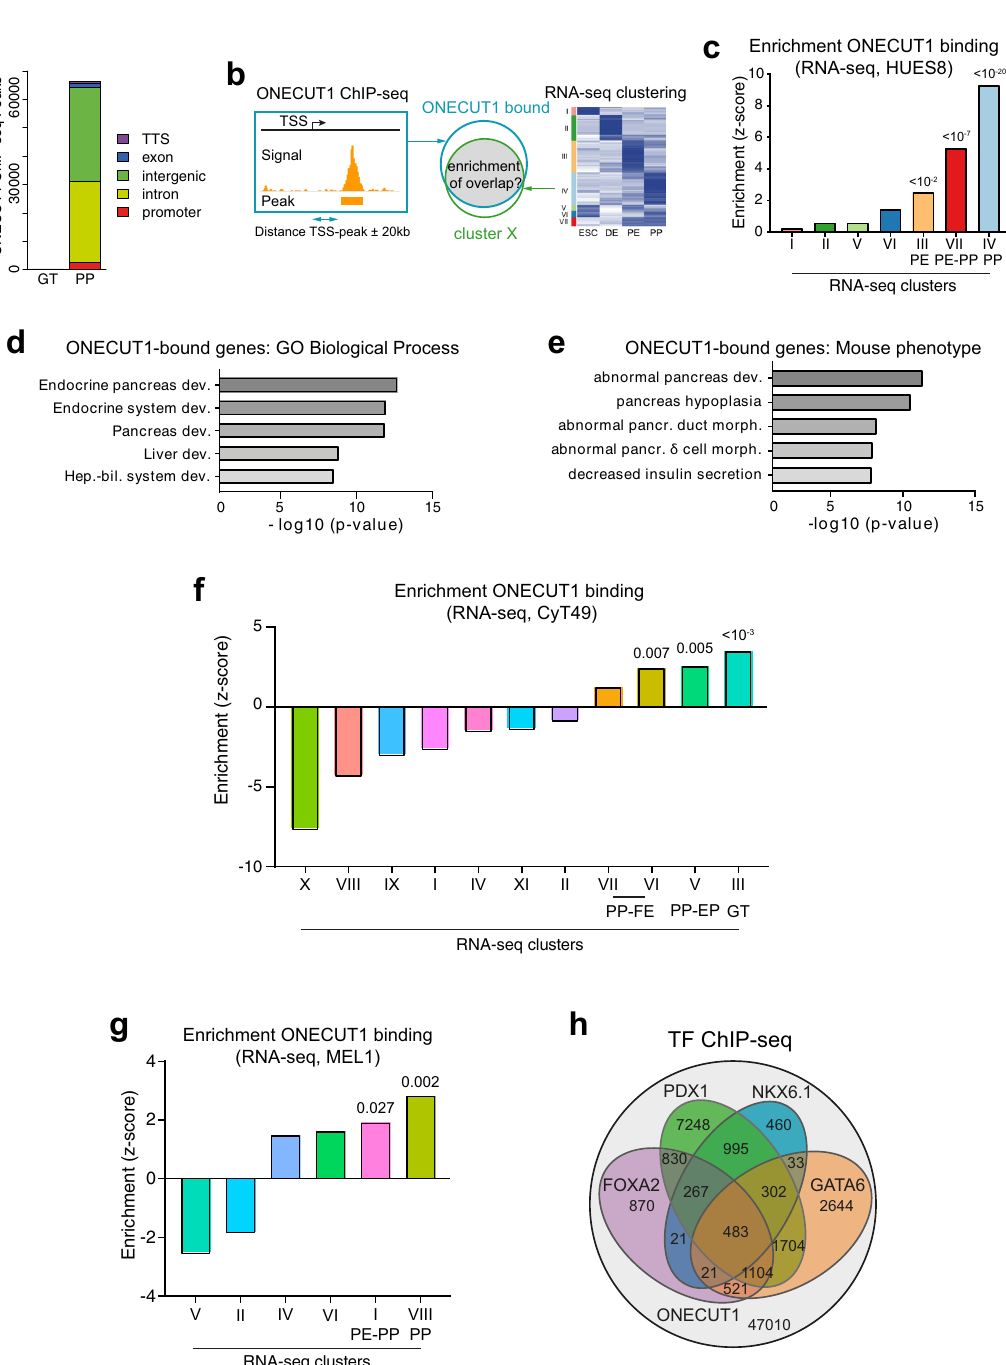
Fig. 3 ONECUT1 binds to regulatory gene clusters relevant for pancreas and endocrine development. a Distribution of ONECUT1 ChIP-seq peaks at GT and PP stages relative to genomic regions. b Schematic of the binding enrichment analysis evaluating whether ONECUT1-bound genes (binding observed 20 kb upstream or downstream of the respective promoter regions) are enriched in particular RNA-seq clusters. c Binding enrichment ( z -score) test of ONECUT1 (ChIP-seq, PP stage) in genes of the RNA-seq clusters of HUES8 cells ( z -test; one-sided). d , e Enrichment analysis (GREAT 36 ) of ONECUT1- bound genes (ChIP-seq, PP stage) (Fischer Exact test; one-sided). f Binding enrichment ( z -score) test of ONECUT1 (ChIP-seq, PP stage) in genes of the RNA-seq clusters of CyT49 cells ( z -test; one-sided). Signi fi cance is indicated above bars (Fischer Exact test; one-sided). g Binding enrichment test of ONECUT1 (ChIP-seq, PP) for MEL1 RNA-seq speci fi c gene clusters. Data show binding score ( z -score) with p -value ( z -test; one-sided). h Overlap of ONECUT1 ChIP-seq peaks (PP stage, own data set) with peaks from other TFs (previously published at GSE54471, GSE149148, or NKX6.1; own data set). For the other TFs, only the number of binding peaks overlapping with ONECUT1 is